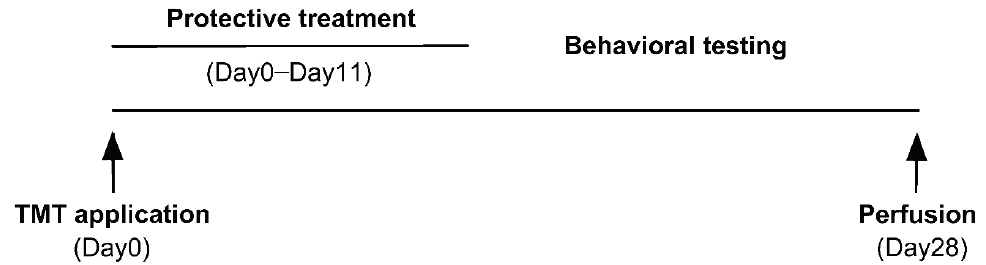
Figure 1. Timeline of the experiment.